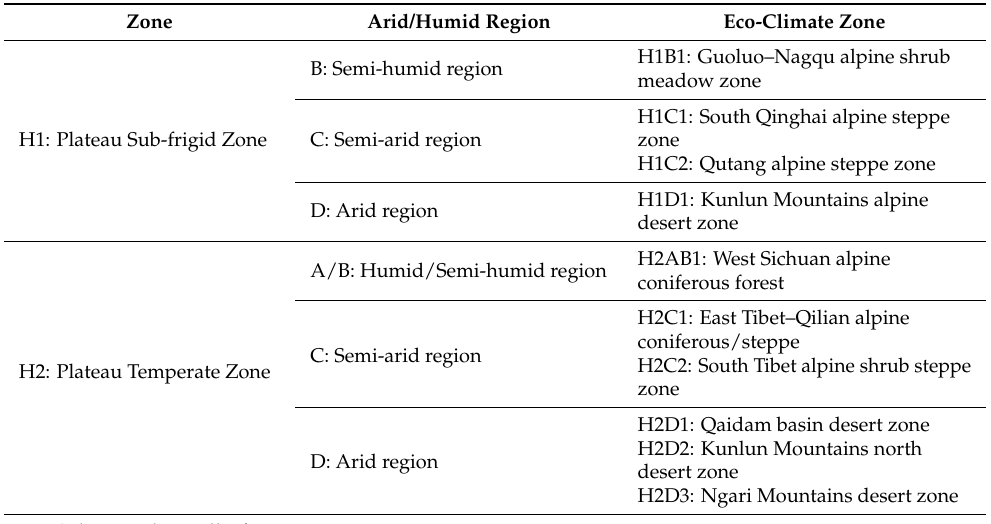
Table 1. Eco-climate zones on the